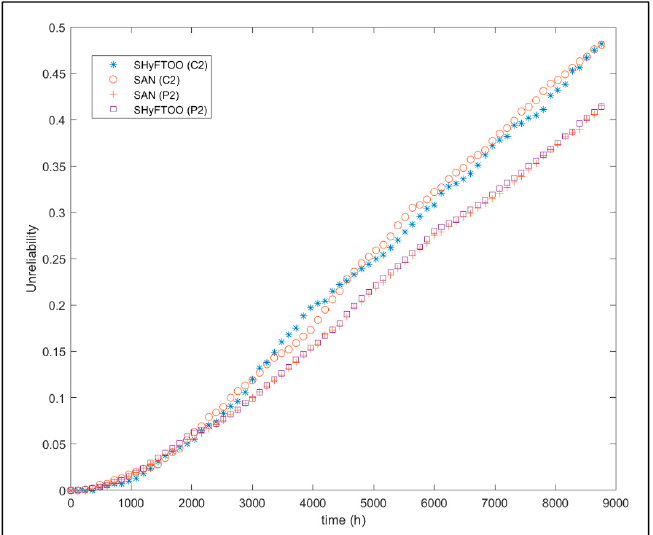
Figure 6. System unreliability for the AND benchmark comparing SAN (Stochastic Activity Net- works) and SHyFTOO